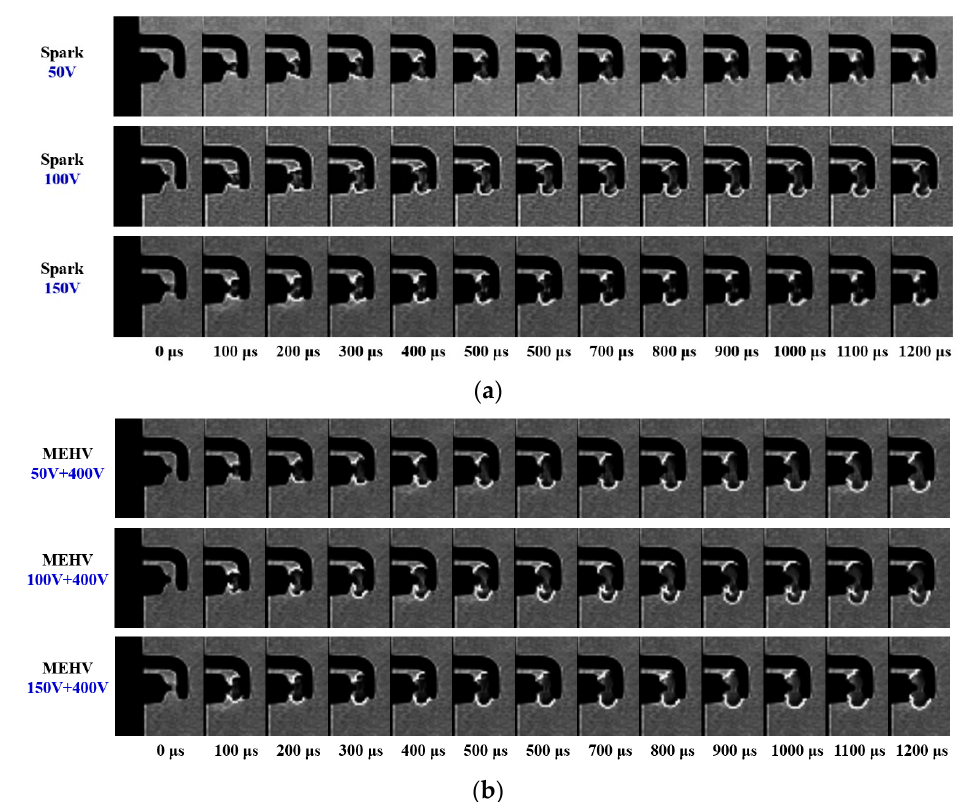
Figure 9. Comparison result of conventional spark and MEHV sparks, which is physically propagated between plug electrodes in the atmospheric air: ( a ) Effect of conventional spark propagation; ( b ) Effect of MEHV spark propagation.